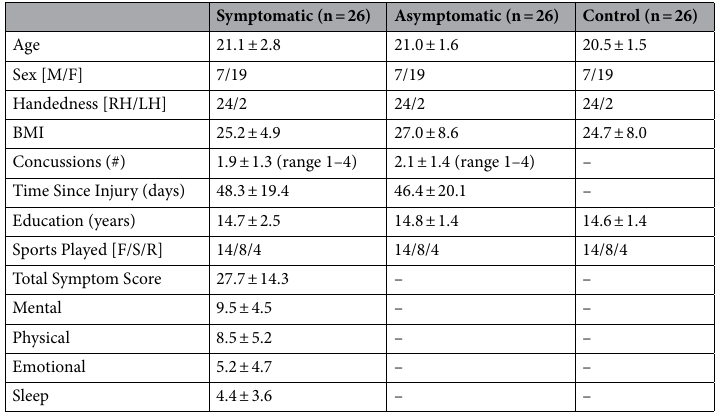
Table 1. Summary demographic and symptom profiles for and symptomatic and asymptomatic concussed athletes, and non-concussed controls. Means are reported with standard deviations. Abbreviations: Sex [M, Males; F, Females]; Handedness [RH, Right-Handed; LH, Left-Handed]; Sport Played [F, Football; S, Soccer; R,